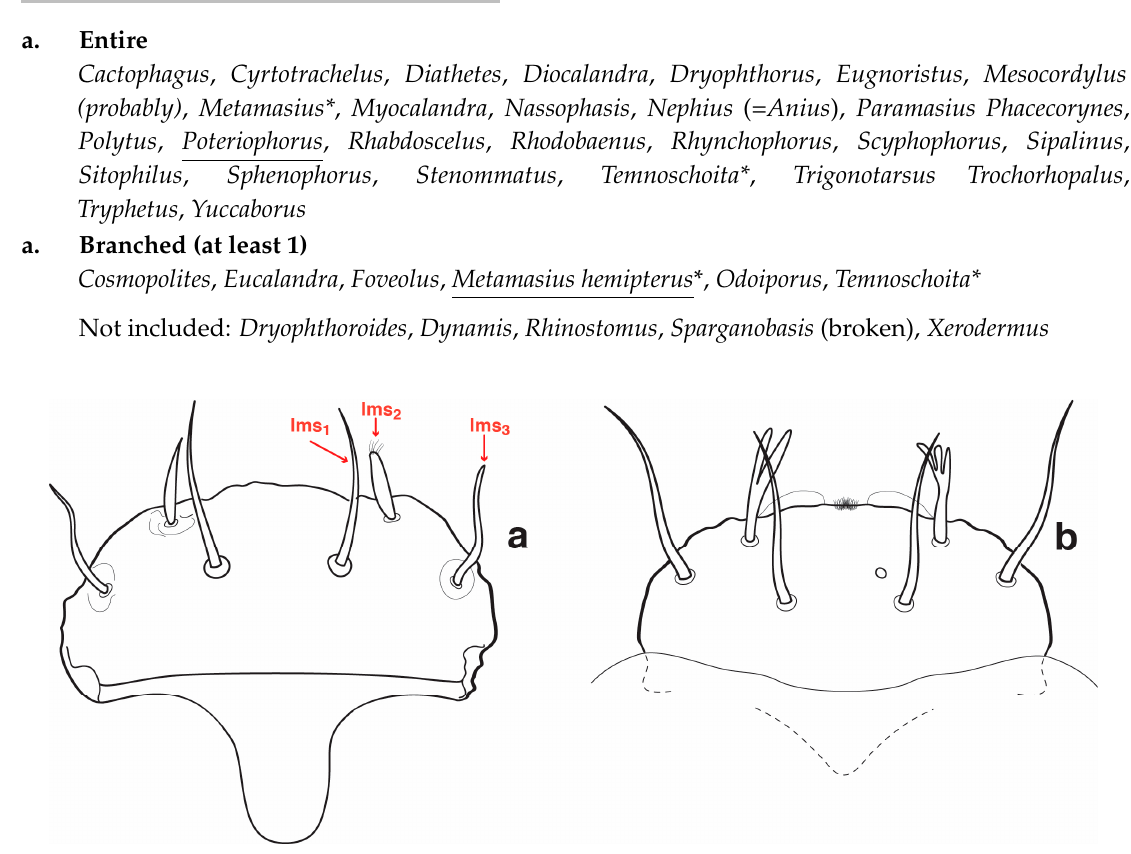
Figure 15. Labrum, larva: ( a ) Poteriophorus sp.; and ( b ) Metamasius hemipterus ; lms1–3 : labral